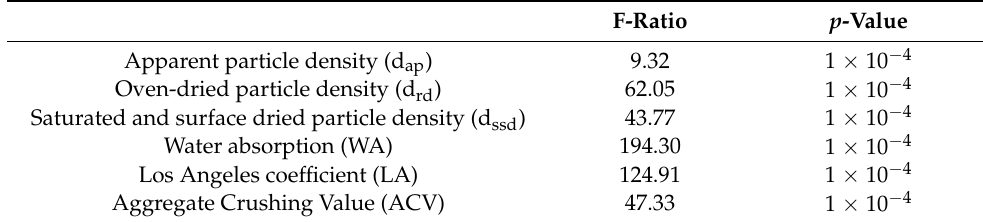
Table 3. One-way Table 3. One-way ANOVA.